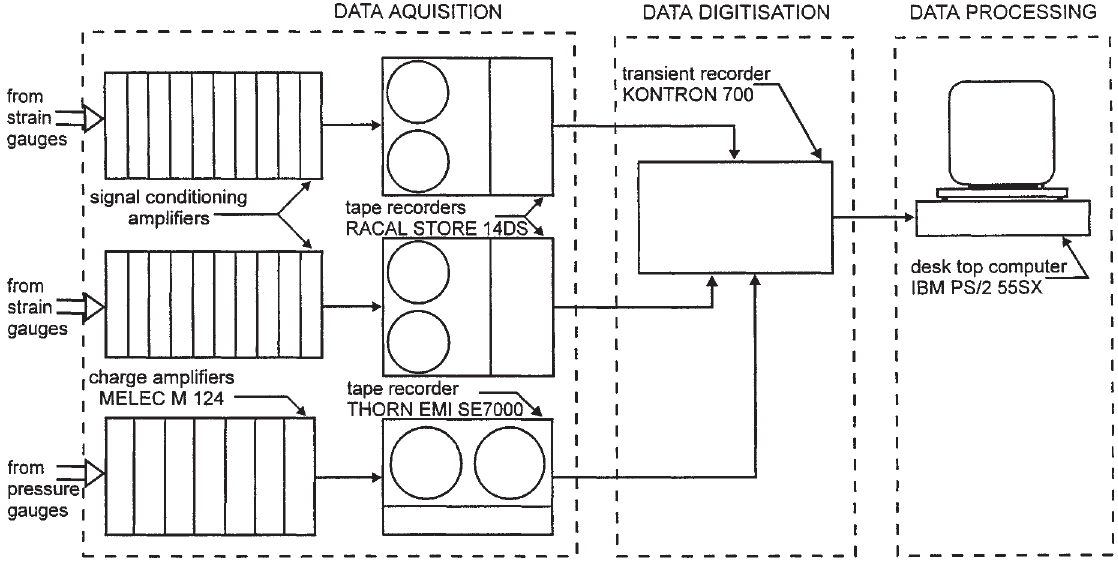
Fig. 5. Data acquisition and analysis instrumentation used in underwater explosion tests.